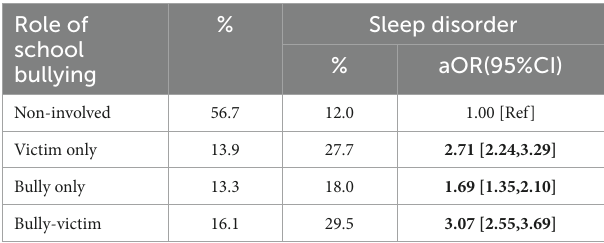
TABLE 4 Multivariate logistic regression of adolescent sleep disorder on role in school bullying ( N =